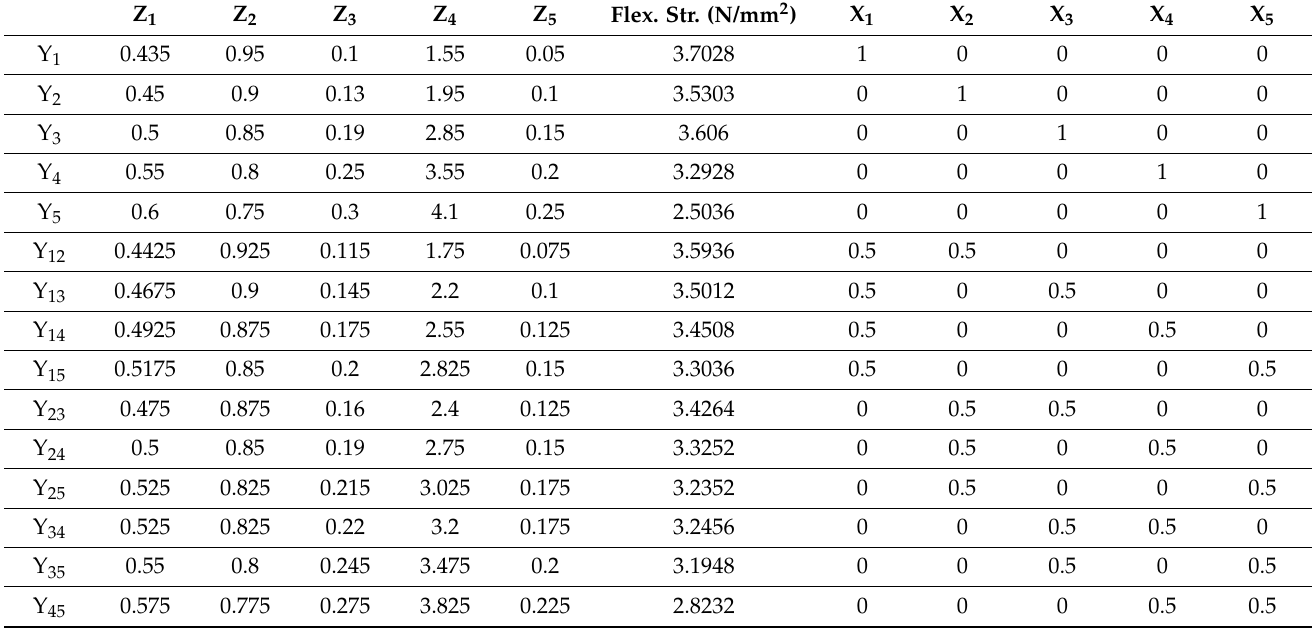
Table 6. Flexural strength response for the experimental